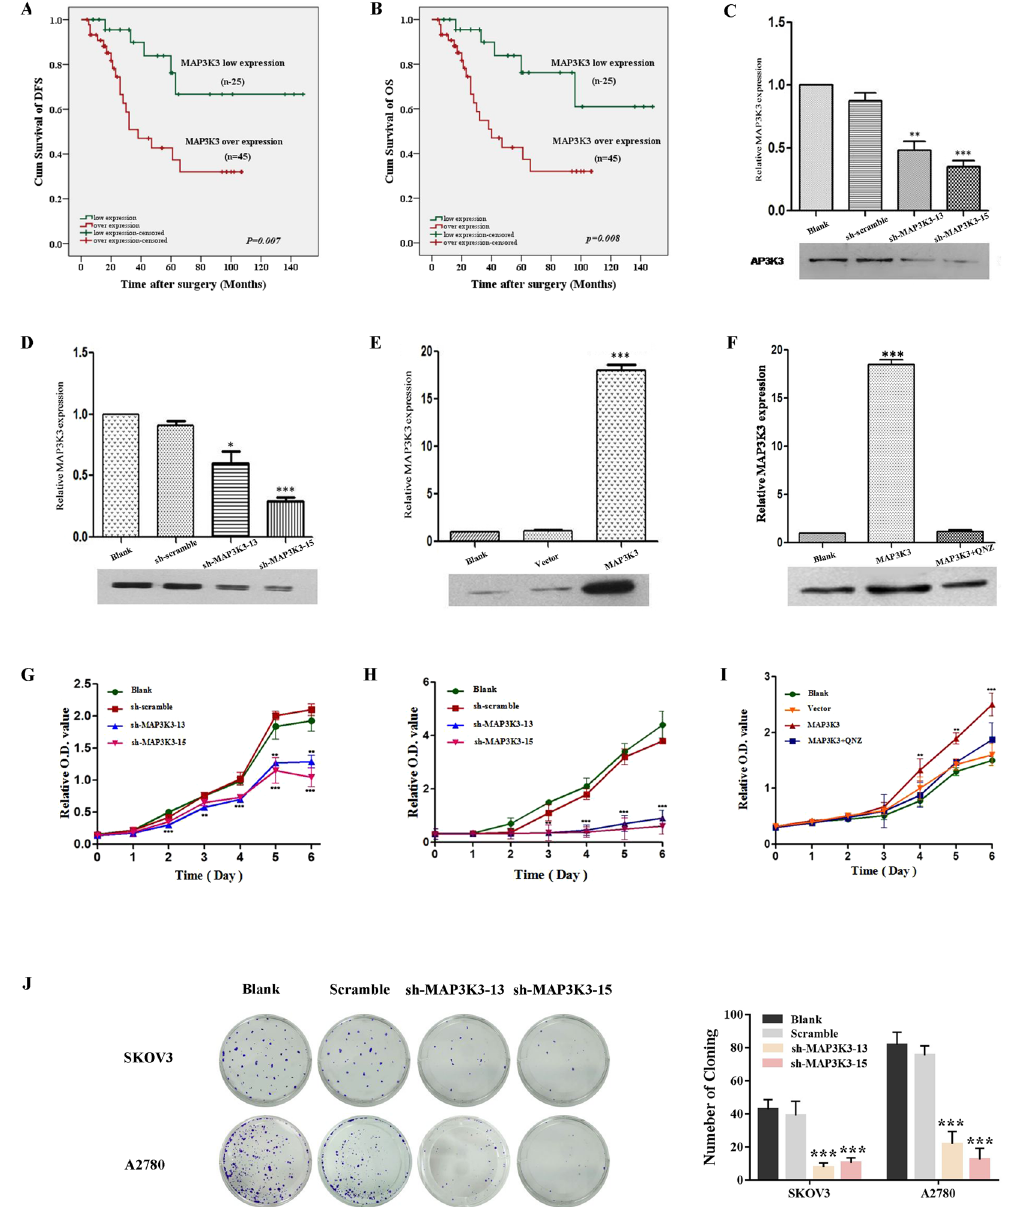
Figure 1. MAP3K3 was positively correlated with survival in HGSOC patients and affected human OC cell proliferation. Patients with MAP3K3 overexpression had shorter disease-free survival ( A ) and overall survival ( B ) than those with low MAP3K3 expression ( P = 0.007, P = 0.008, respectively). The expression of MAP3K3 protein was detected by transfecting scramble and sh-MAP3K3 in SKOV3 ( C ) and A2780 ( D ) cells, and the protein expression of MAP3K3 was detected by transfecting MAP3K3 ( E ) and MAP3K3 + QNZ ( F ) in OV2008 cells. The CCK-8 assay ( G , H ) was used to detect cell proliferation, and a colony formation assay ( J ) was used to detect the colony forming ability of SKOV3 and A2780 cells. Effect of the overexpression of MAP3K3 and blocking the NF- κ B signalling pathway (MAP3K3 + QNZ) in OV2008 cells on proliferation ( I ). Repeated three independent experiments, * means p < 0.05, ** means p < 0.01, *** means p <